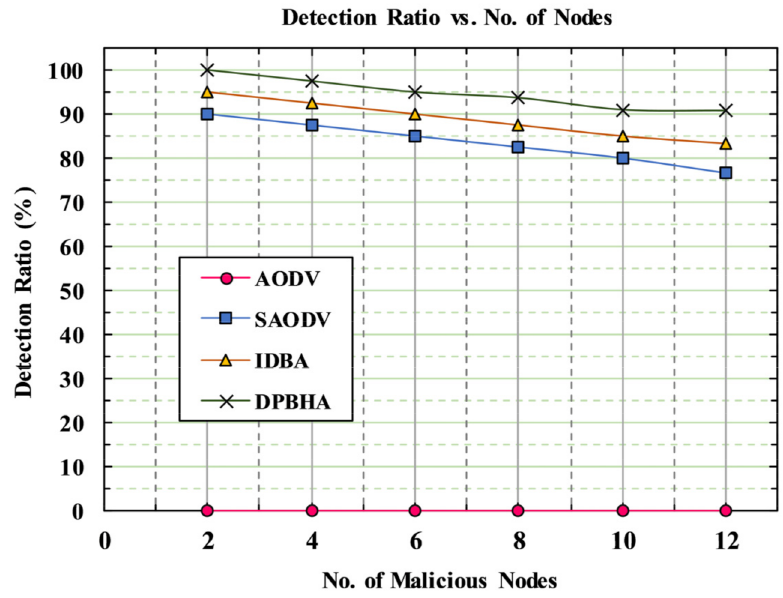
Figure 15. Graphical representation of detection rate.